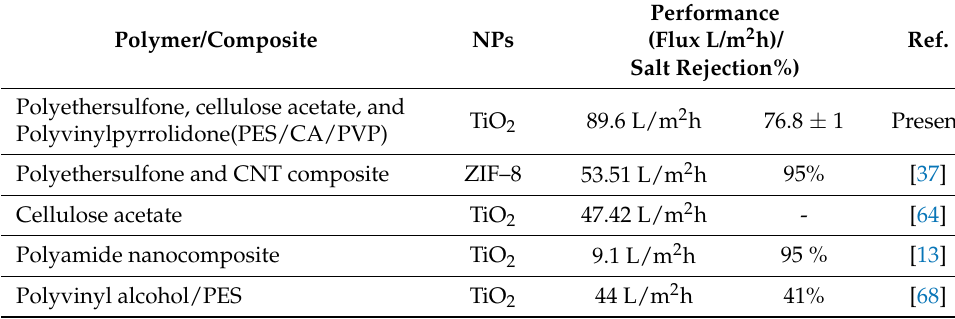
Table 3. Comparison between previous studies and the current study.